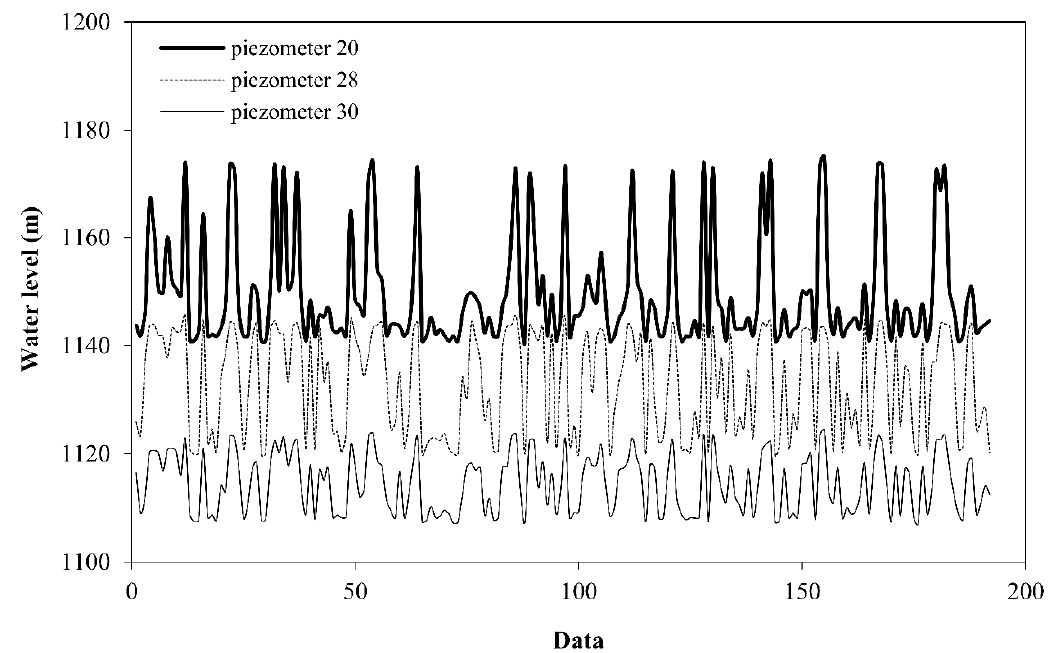
Figure 2. Historical variations of water level in the three studied piezometers in this research.